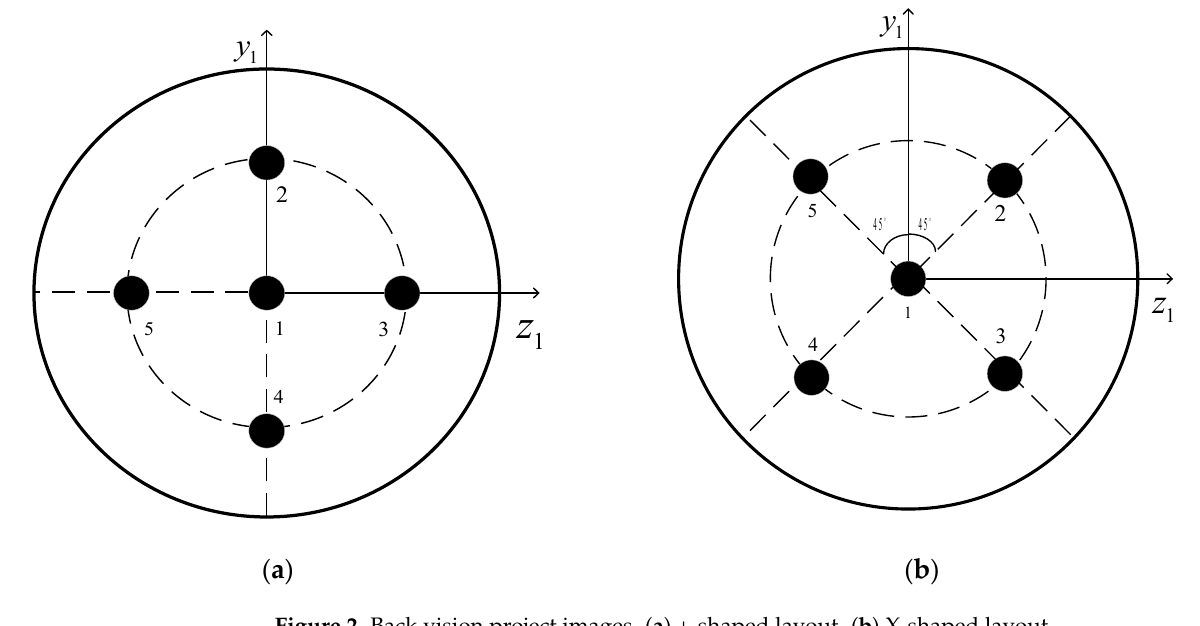
Figure 2. Back vision project images. ( a ) +-shaped layout. ( b ) X-shaped layout.